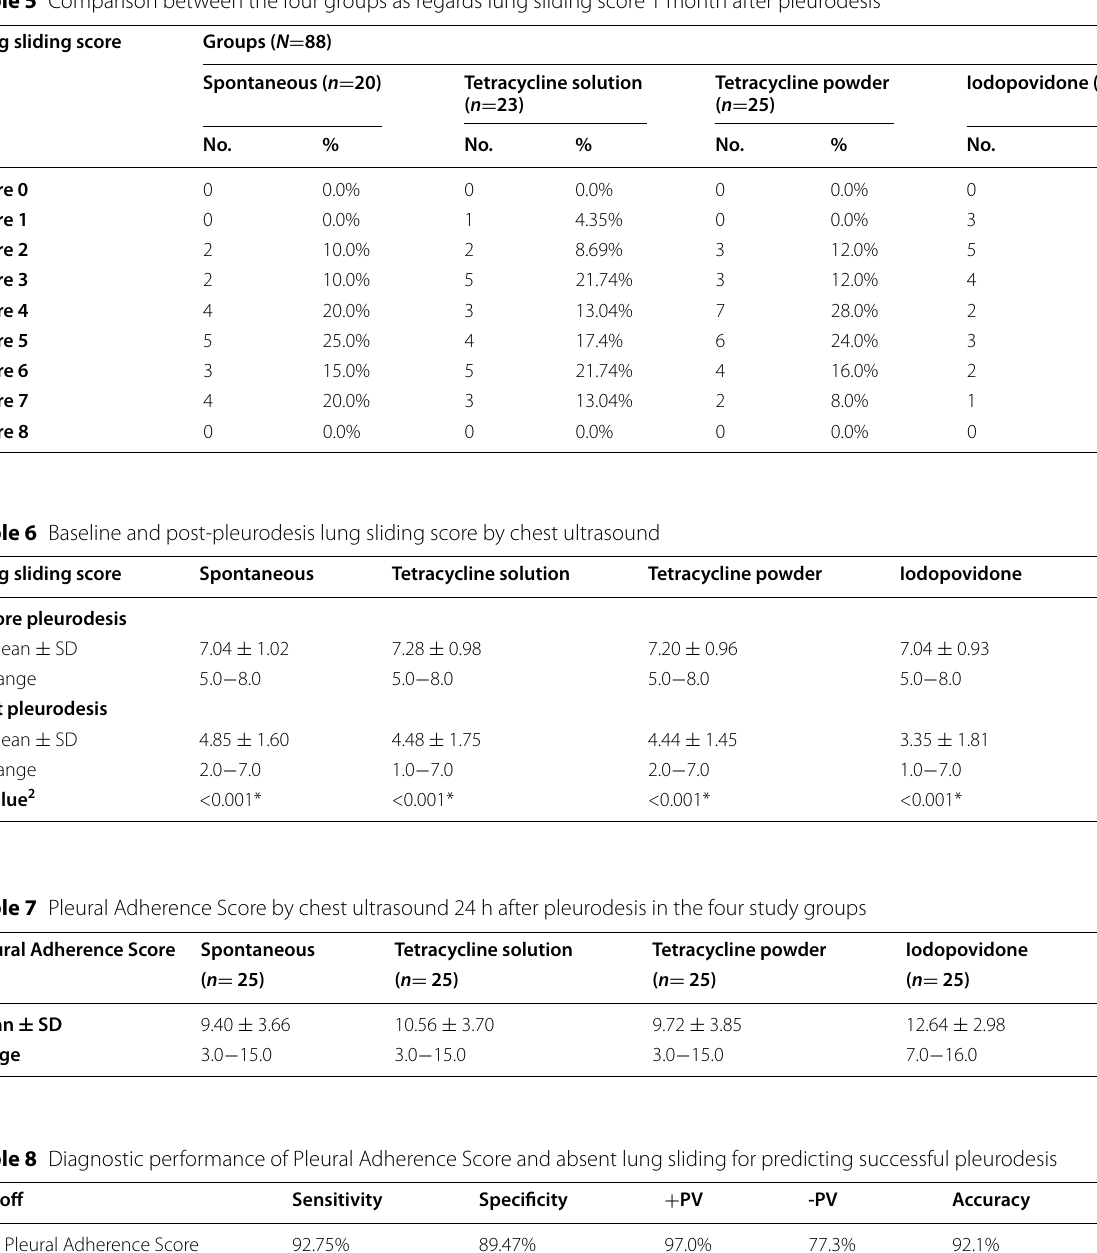
PV predicted value, AUC area under the curve